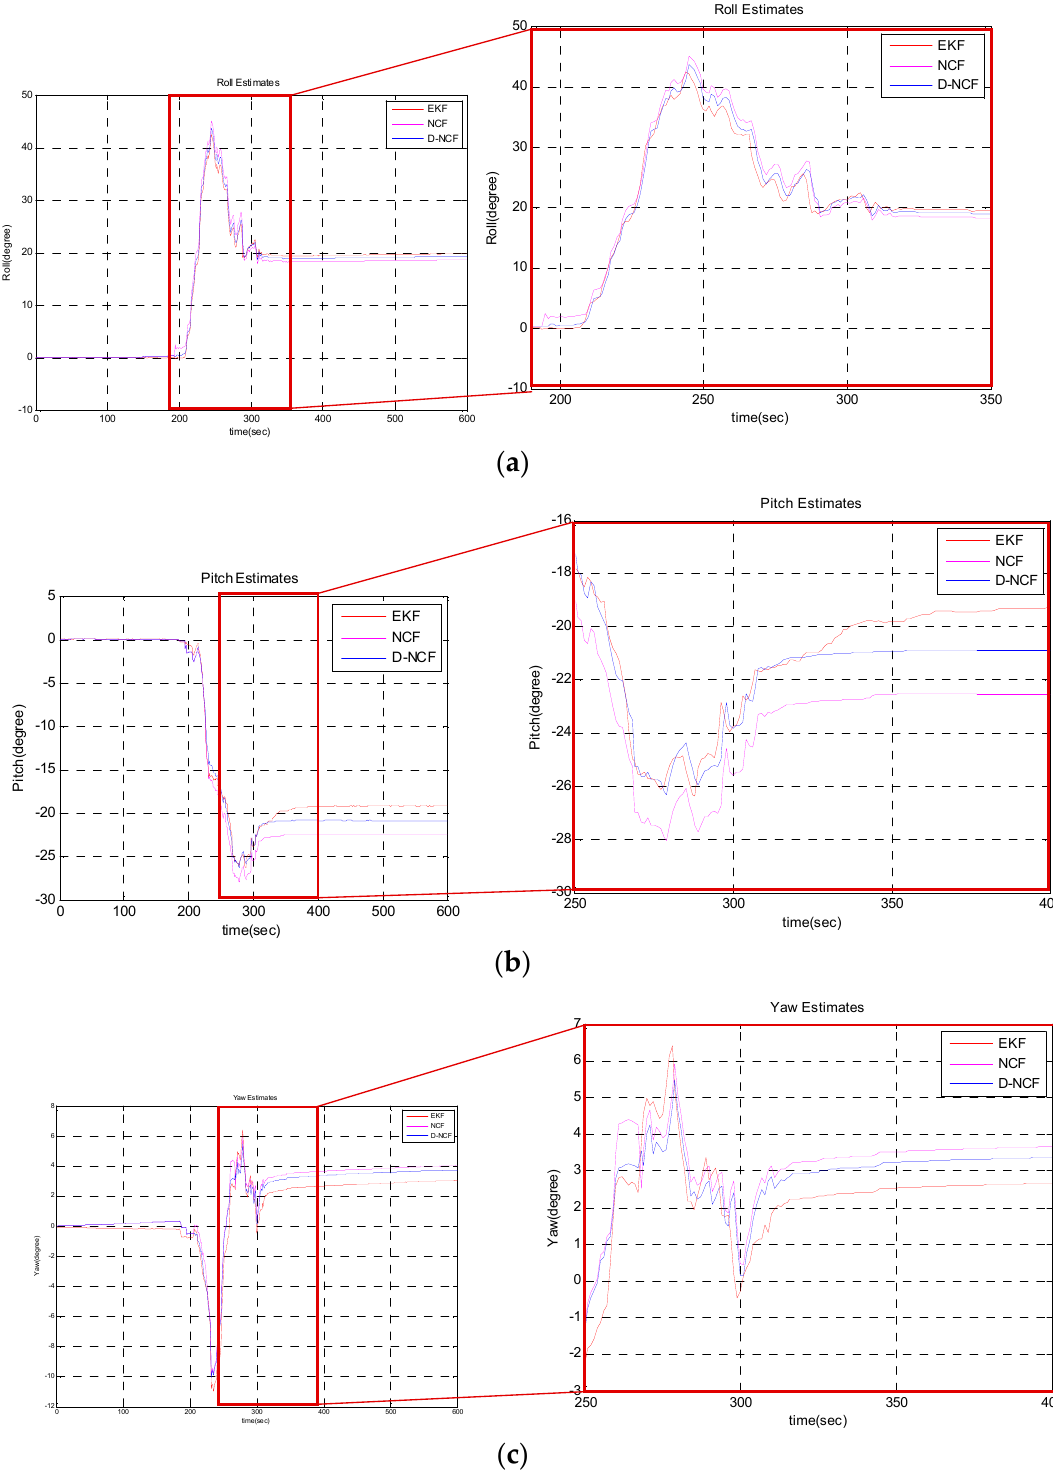
Figure 5. Comparison of attitude estimation accuracy between EKF, NCF and D-NCF algorithm: ( a ) estimated result of roll angle by using EKF, NCF and D-NCF algorithm respectively; ( b ) estimated result of pitch angle by using EKF, NCF and D-NCF algorithm respectively; ( c ) estimated result of yaw angle by using EKF, NCF and D-NCF algorithm respectively.